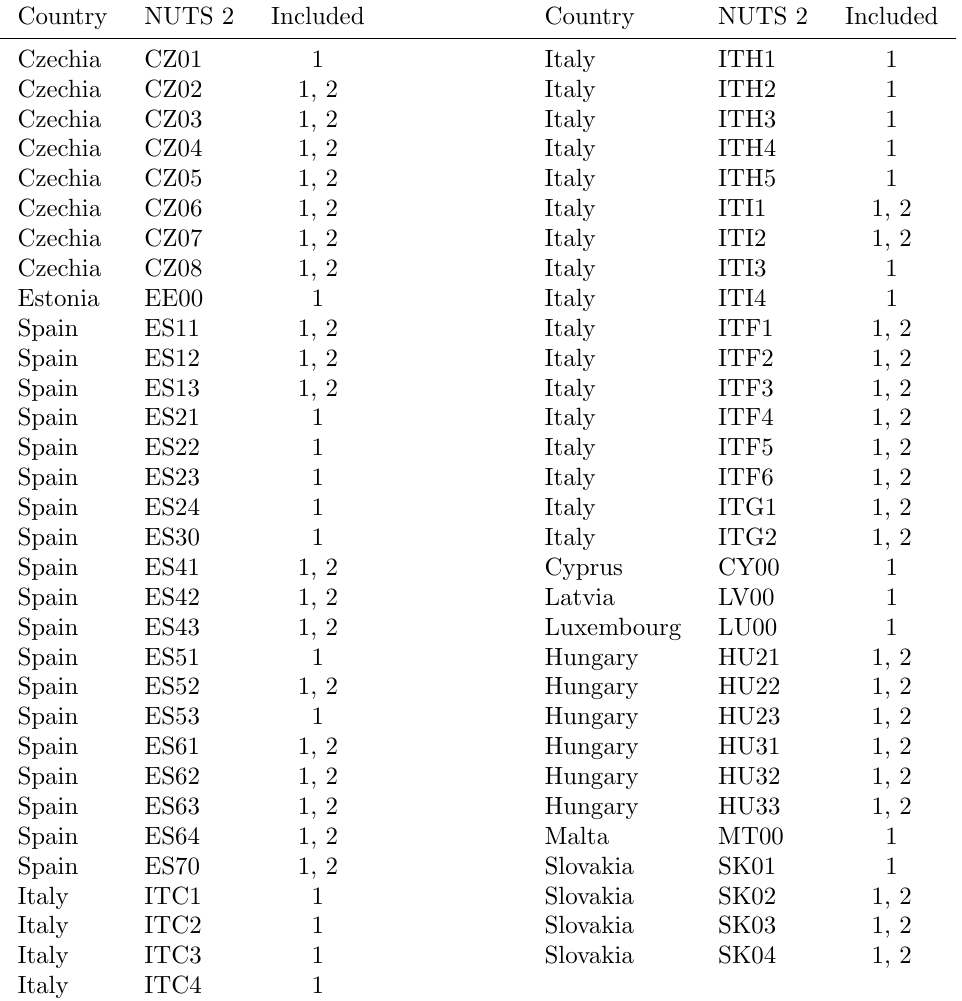
Table 1: Summary of NUTS2 Regions Included in Stage 1 (Table 3) and Stage 2 (Table 4) of the